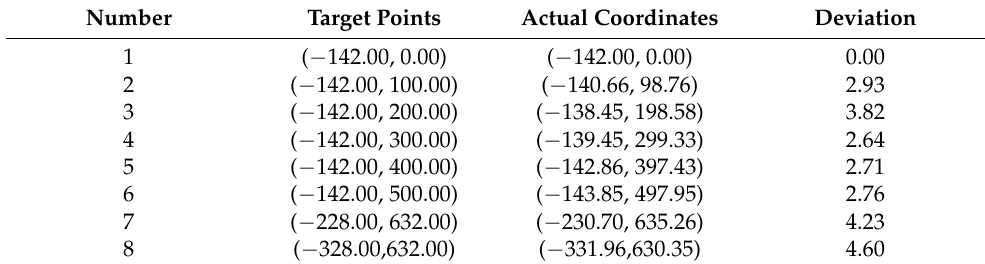
Figure 17. Two-dimensional map of specific paths. ( a ) Two-dimensional map of the “L” trajectory, ( b ) Two-dimensional map of the “U” track. Table 2. “L” path cruise test data Unit: cm.